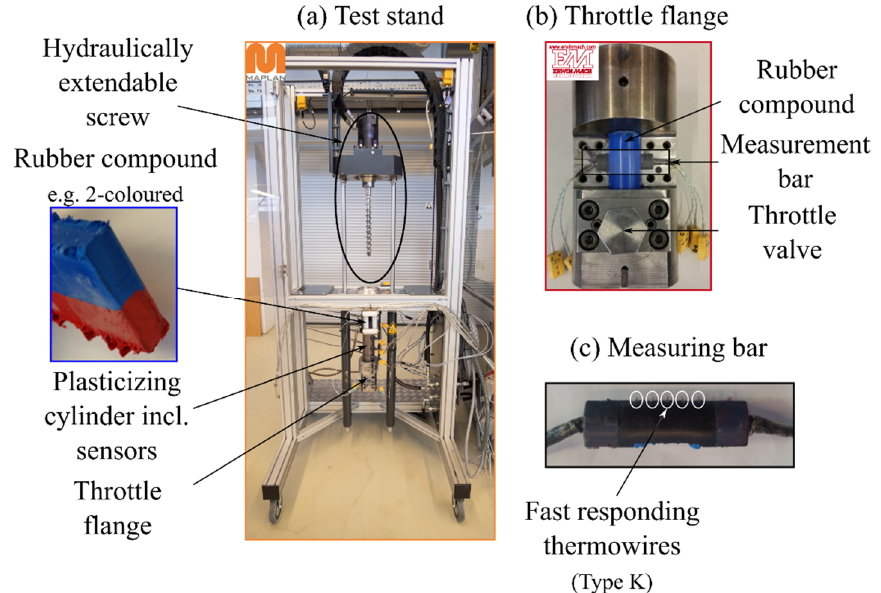
Figure 1. Test stand used for the process-orientated determination of the axial mass temperature profile during dosing: ( a ) test stand consisting of a “First-In-First-Out” dosing unit with sensors and equipped with a ( b ) throttle flange that contains the ( c ) measuring bar [18].